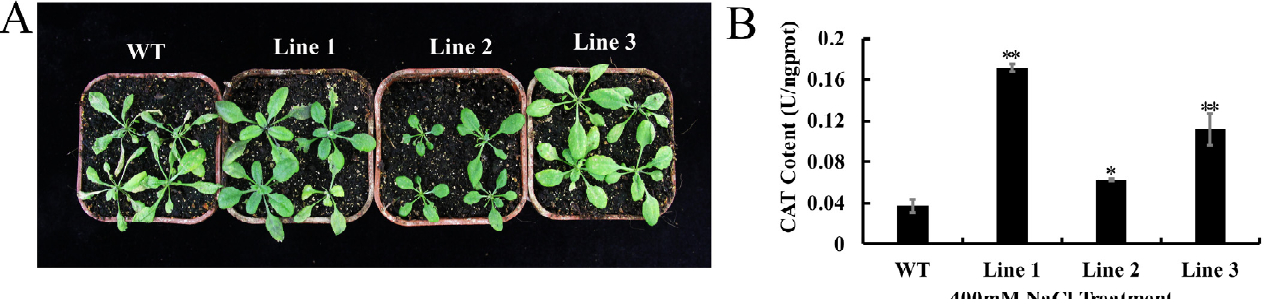
Figure 5. Phenotype and the content of CAT in WT Arabidopsis and three transgenic Arabidopsis lines under 400 mM NaCl treatment. ( A ) The phenotype of WT Arabidopsis and three transgenic Arabidopsis lines under 400 mM NaCl treatment. ( B ) The content of CAT in WT Arabidopsis and three transgenic Arabidopsis lines under 400 mM NaCl treatment. The error bars represent standard deviations of three biological replicates (* p < 0.05, ** p < 0.01, Student’s t -test).